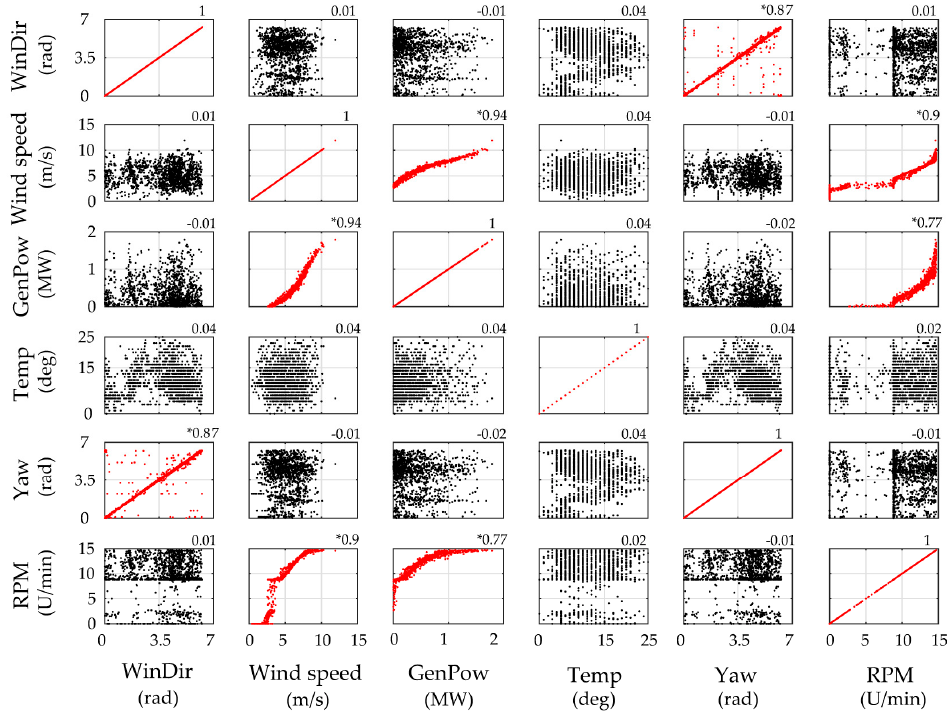
Figure 12. Scatter plots of selected PCE input variables and estimated correlation values (Case A).